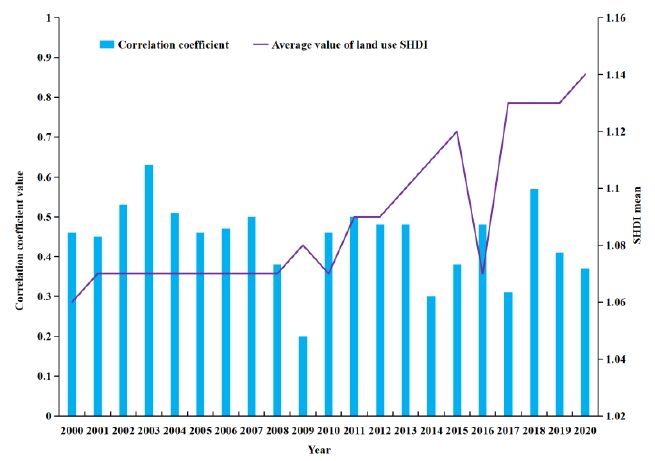
Figure 10. Correlation analysis between land use SHDI and LST from 2000 to 2020 (Significant correlated at the 0.01 level (2-tailed)). Table 5. Regression analysis of land use SHDI and LST from 2000 to 2020.